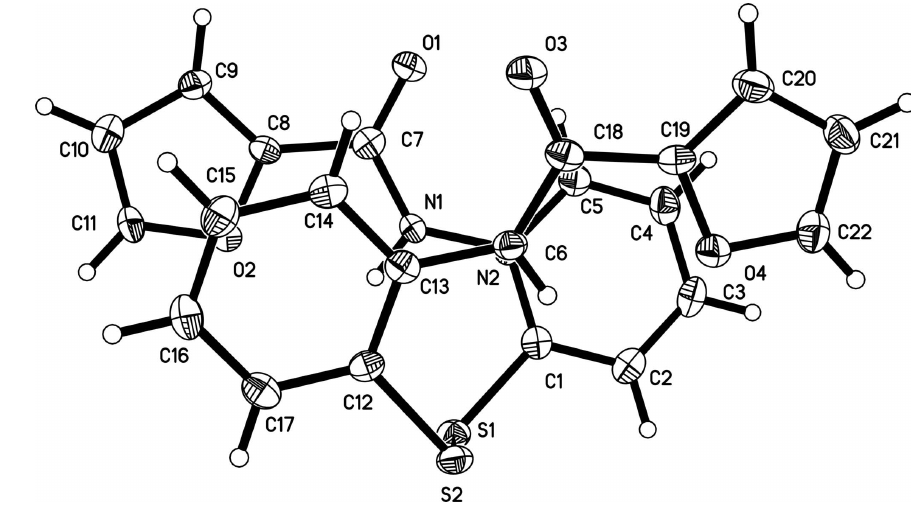
View of (I) along the S—S bond showing the sense of twist (50% probability displacement